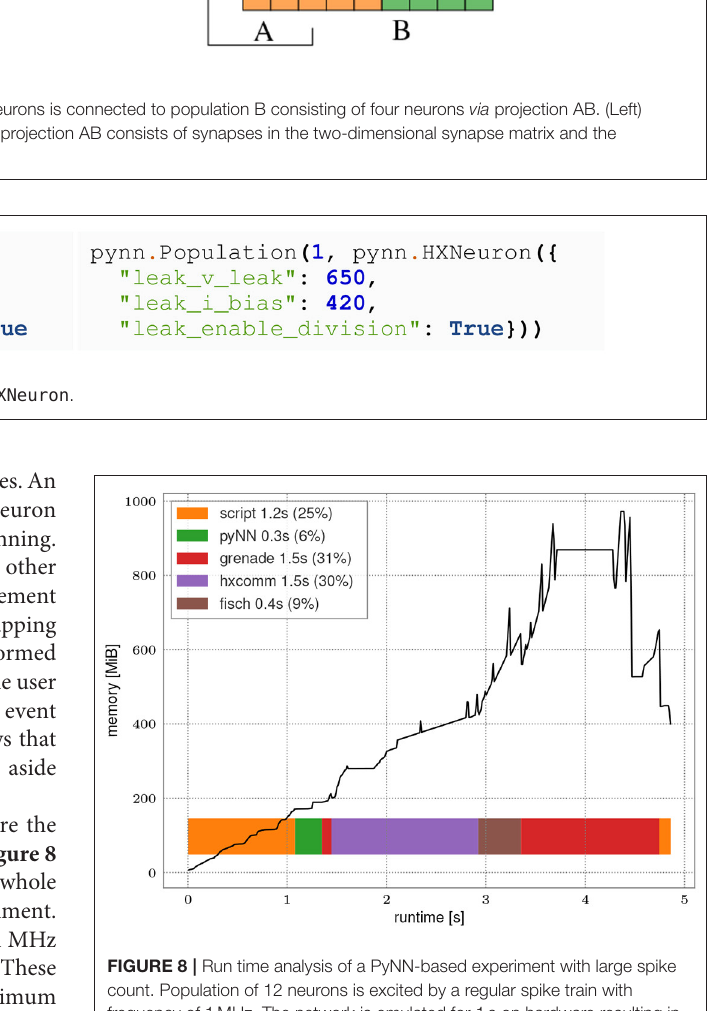
FIGURE 8 | Run time analysis of a PyNN-based experiment with large spike count. Population of 12 neurons is excited by a regular spike train with frequency of 1MHz. The network is emulated for 1s on hardware resulting in 1.2 × 10 7 spike events. The black line represents memory consumption during execution. Horizontal bars represent time consumption in software layers. The annotations in the legend present the individual run time of steps and percentage of the overall run